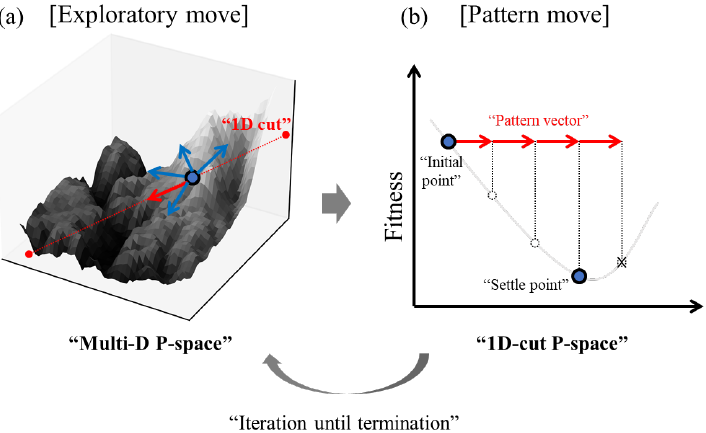
Figure 1. The graphical conceptualization of the exploratory move and pattern move of patter search algorithm: ( a ) Exploratory move. In the multi-dimensional parameter space, adjacent points around the exploration basis (blue dot surrounded by black line) are evaluated in the process and the displacement between best point and the exploration basis is set to pattern vector (red arrow). 1-dimensional projection along the pattern vector will be the stage for the following process; ( b ) Pattern move. One-dimensional naïve line search is performed with the given pattern vector. The process is terminated when the newest point is not improved more then set the previous point to be the next exploration basis (settle point).